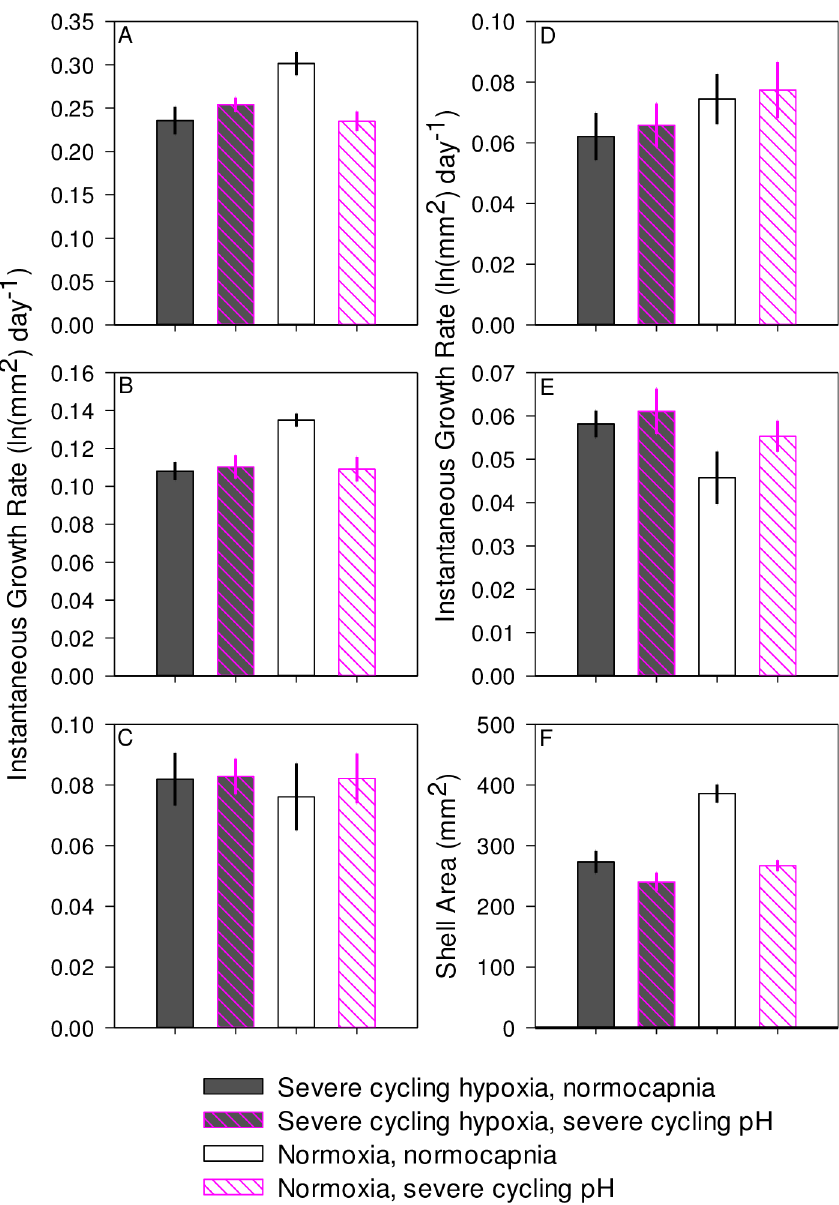
Fig 5. 2015 juvenile growth experiment. Mean ± 1 SE instantaneous rate of growth by treatment of juvenile oysters exposed to diel cycles 7 d wk -1 during (A) first week, (B) second week, (C) third week, (D) fourth week, (E) fifth week, and (F) mean ± 1 SE shell area at the end of the five week laboratory